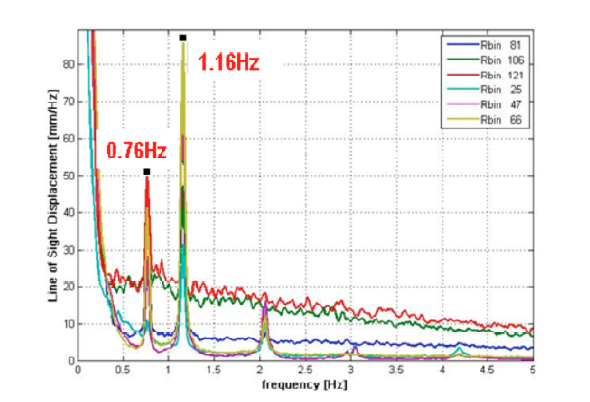
Figure 7. Values of the maximum displacements retrieved from radar acquisition depicted in the corresponding point of the bridge Using Welch (1967) method, an estimate of the power spectral density (PSD) has been calculated for the time history of different bins. In Figure 8 the PSD corresponding to various bins is shown. Some peaks, corresponding to the vibration frequencies of the monitored structure, can be individuated among which 0.76 Hz and 1.16 Hz stand out.